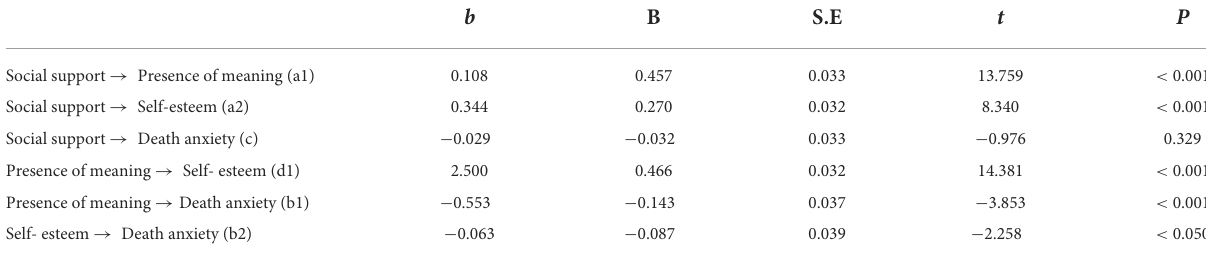
TABLE 3 The unstandardized and standardized path coefficients for all pathways in the model of social support and death anxiety, mediated by presence of meaning and self-esteem ( N = 1,167).